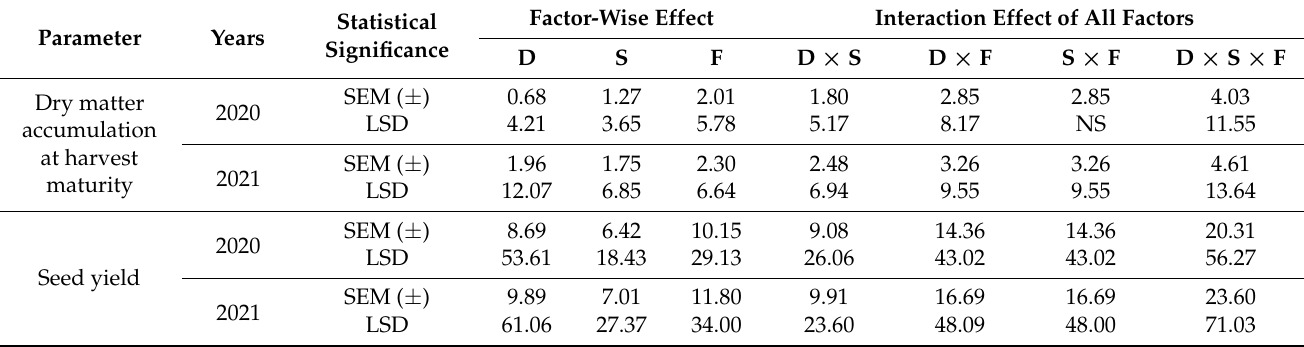
Table 10. Statistical significance and interaction effects of the date of sowing, soil application of Co, and foliar spray with K and B on the final dry matter accumulation and seed yield of black gram during the spring-summer